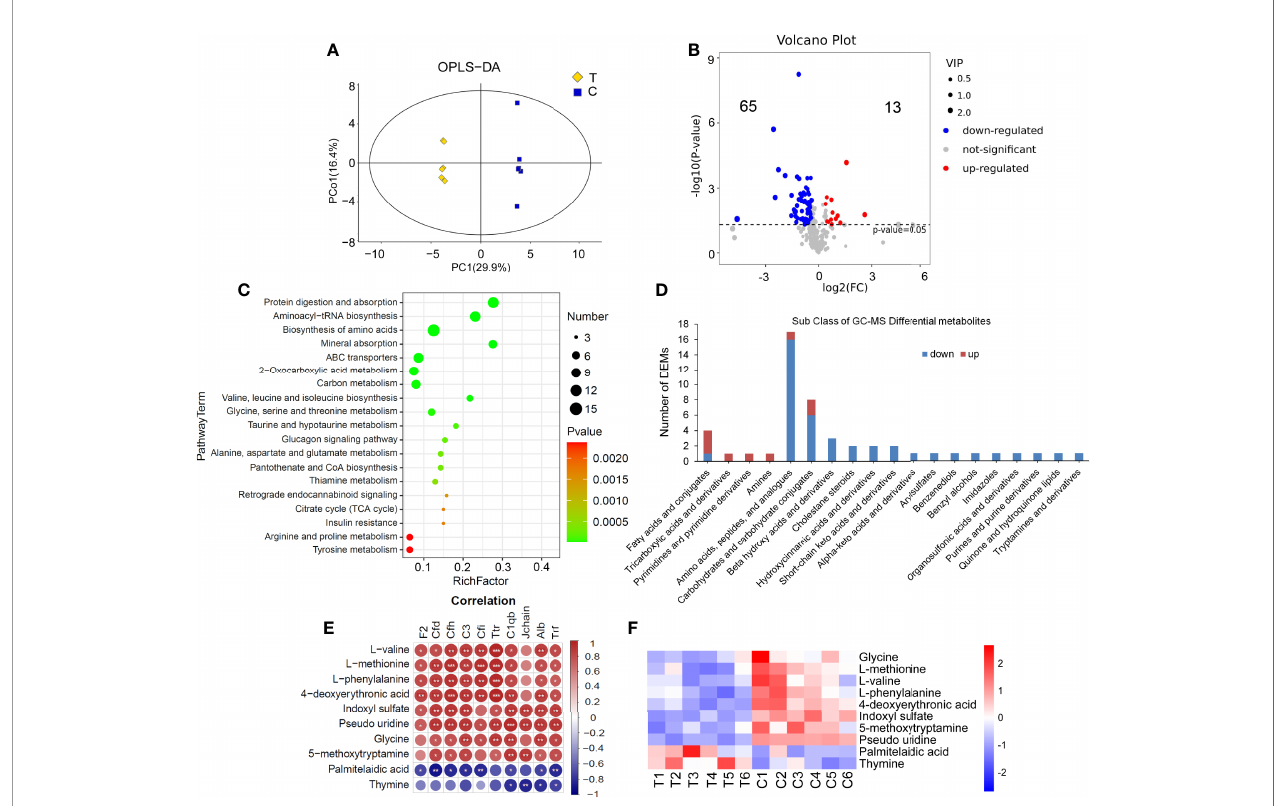
FIGURE 8 | Serum GC-MS metabolomics analysis. (A) There were signi fi cant differences in OPLS-DA score between the thyrotoxicosis group (T) and the normal control group (C). (B) The Volcano plot of 80 lipid DEMs (HMDB database), including 13 upregulated ones and 65 downregulated ones. (C) The KEGG pathway analysis result of all DEMs. (D) The classi fi cation of GC-MS DEMs. (E, F) 13 DEMs that were signi fi cantly correlative with Alb and C1q. T, thyrotoxicosis mice; C, normal control mice. Red is positive correlation and blue is negative correlation, correlation signi fi cance: * p <0.05; ** p <0.01; *** p